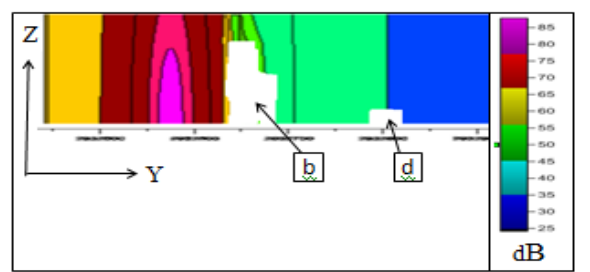
Figure 14. Noise map of academic area of IIT Kanpur. Modelled sound pressure levels (dB) are displayed with colours for all points in DSM due to sound generated by the source placed at S . Points a, b, c, d are positions of buildings. The double sided yellow arrow indicates major unobstructed propagation direction.